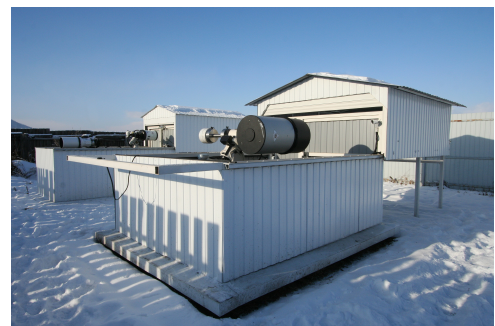
The newest telescopes in this network are well auto- mated and remotely controlled by observers. At the same time, the initial image processing is usually carried out on-site, which avoids a lot of traffic.